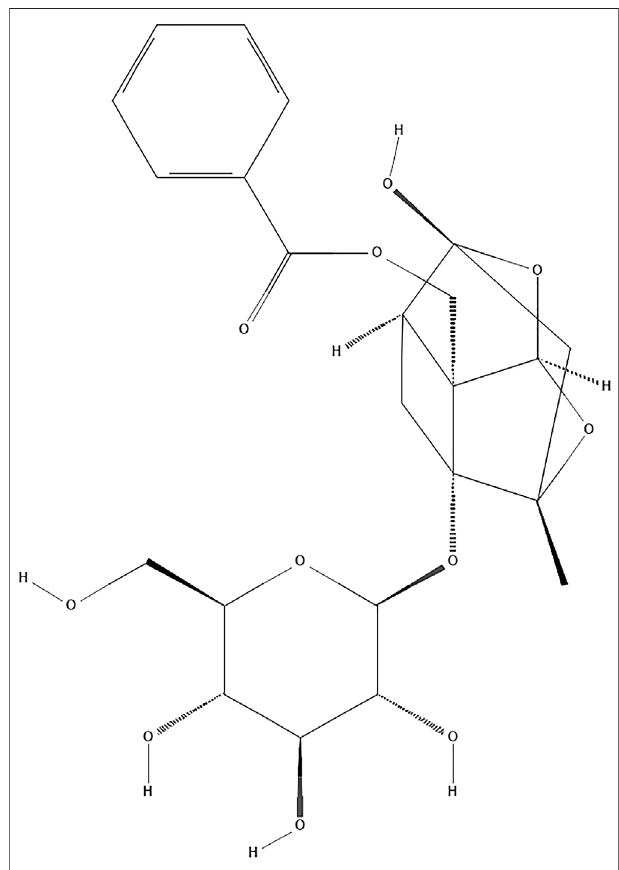
FIGURE 1 | Chemical structure of paeoni fl